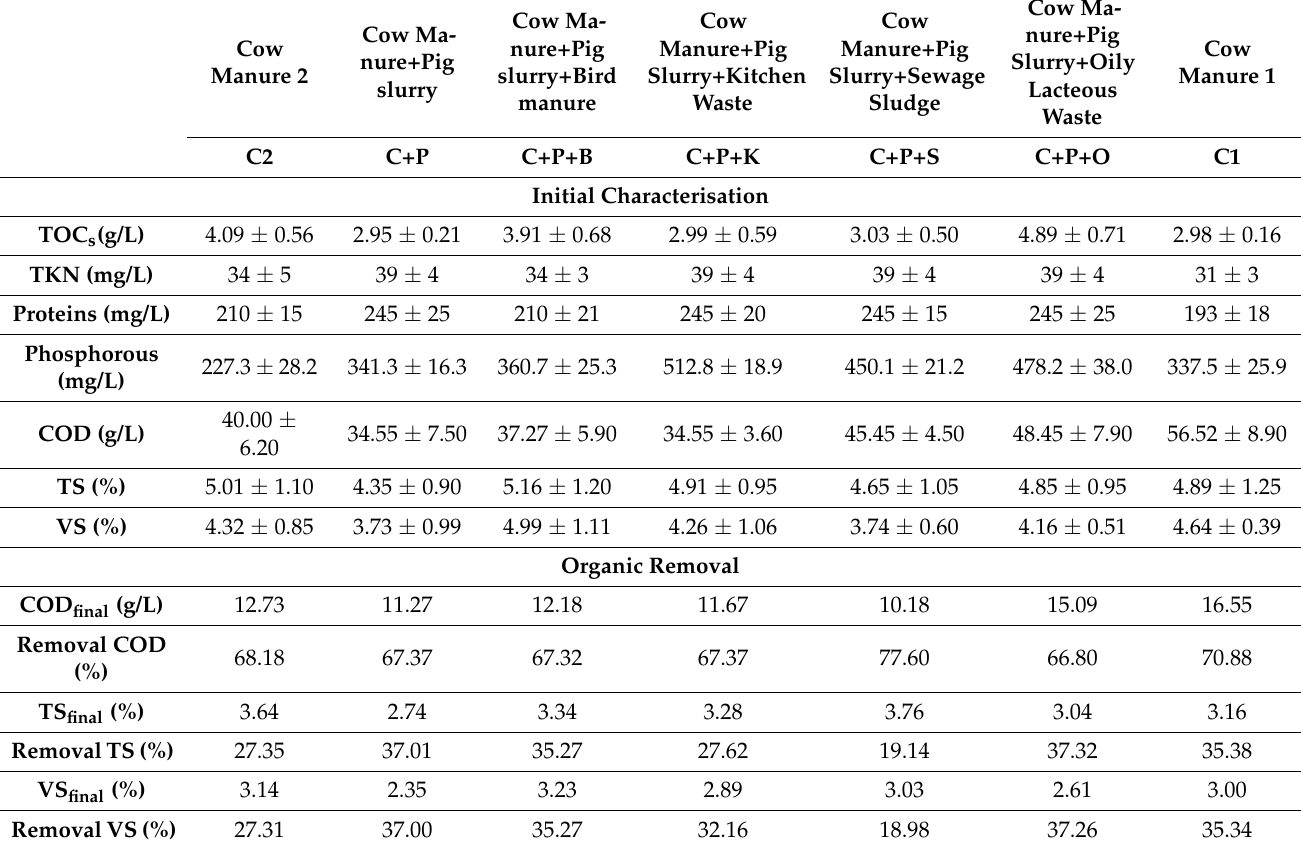
Table 4. Initial characteristics of substrate and organic removal in 60-days